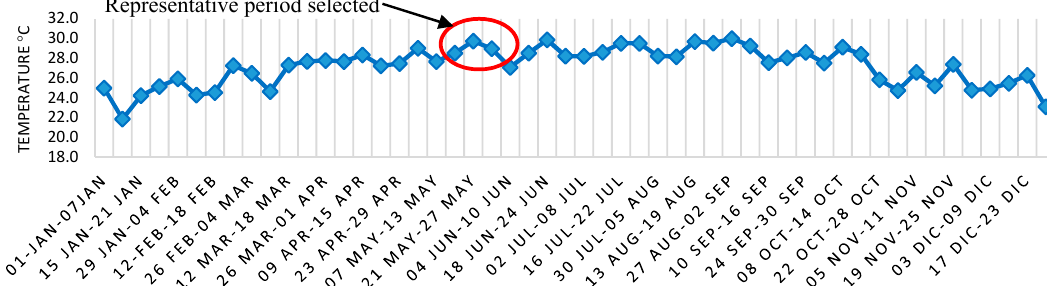
Figure 3. Average temperature of the year based on the typical meteorological year (TMY) file